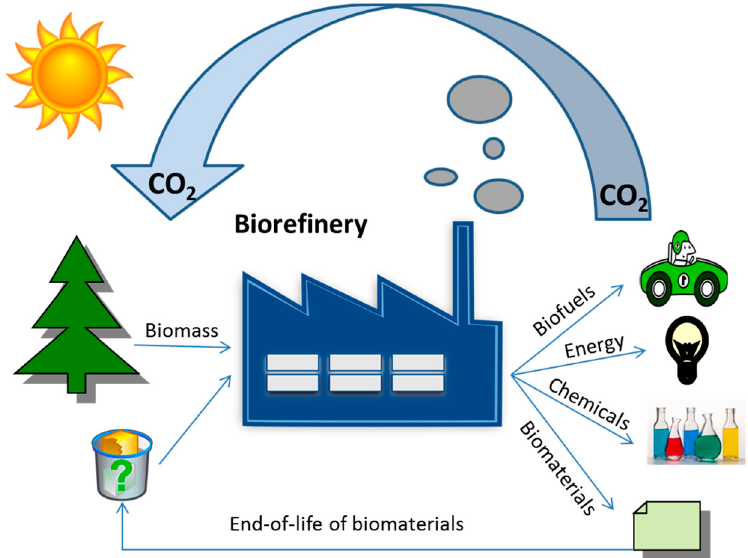
Figure 1. Diagram of a sustainable biorefinery process. Adapted from Ragauskas et al. [11] and Mohan et al. [12].